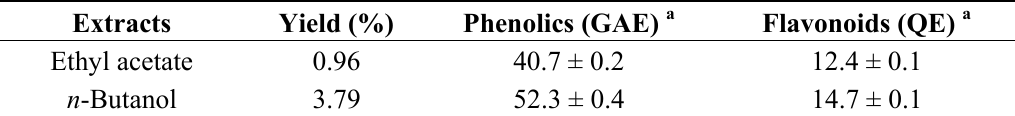
Table 1. Yields and chemical composition of F. lutea flowers